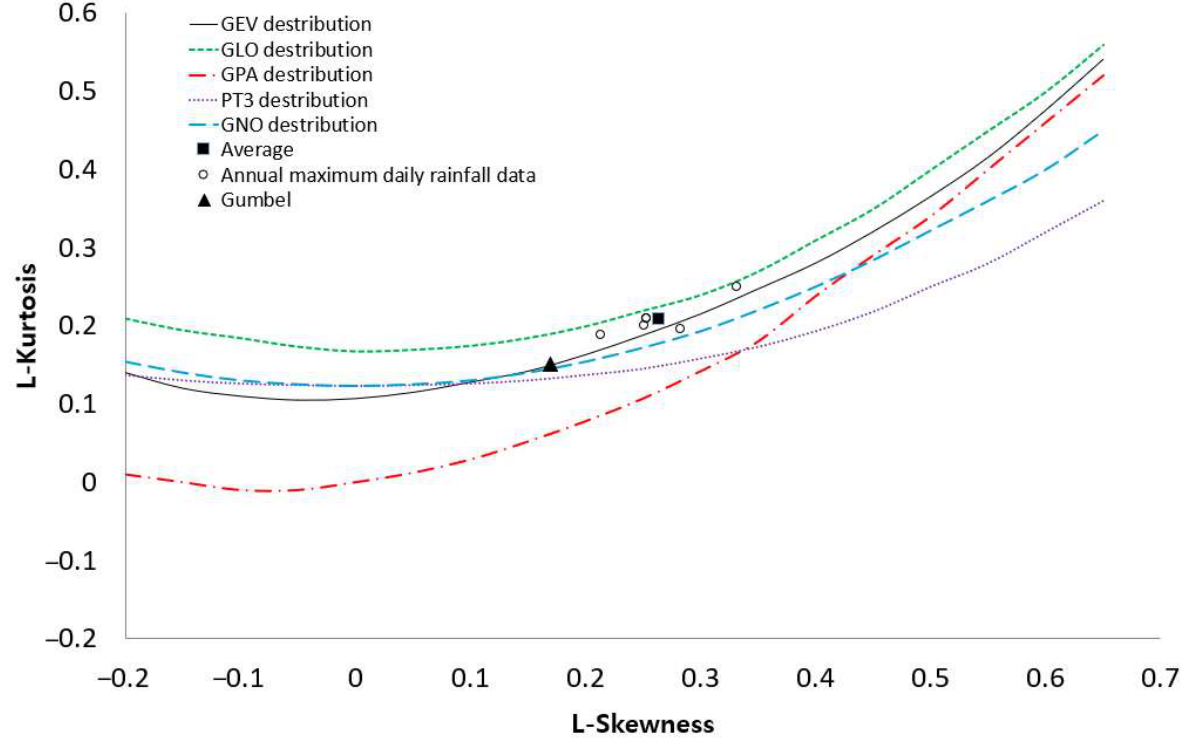
Figure 7. Identification of distributions by L-moment.